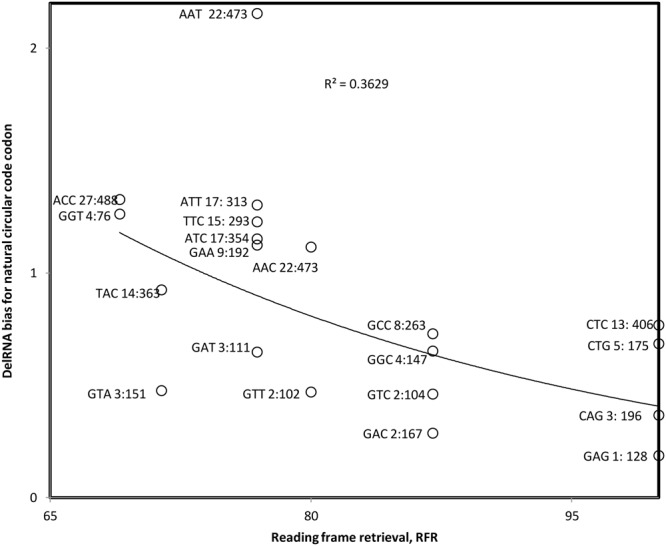
Bias in natural circular code codon contents in detected delRNA3-1 as compared to the rest of the human mitogenome, as a function of the contribution of that codon to RFR. Natural circular code codon identities are indicated near datapoints, together with numbers of codons within delRNAs, followed by that number in the rest of the del-transformed human mitogenome. The Pearson correlation coefficient r = –0.602 (one-tailed P = 0.0025) and the nonparametric Spearman rank correlation coefficient rs = –0.637 (one tailed P = 0.001) indicate that circular code codons with high effects on frame maintenance are avoided.